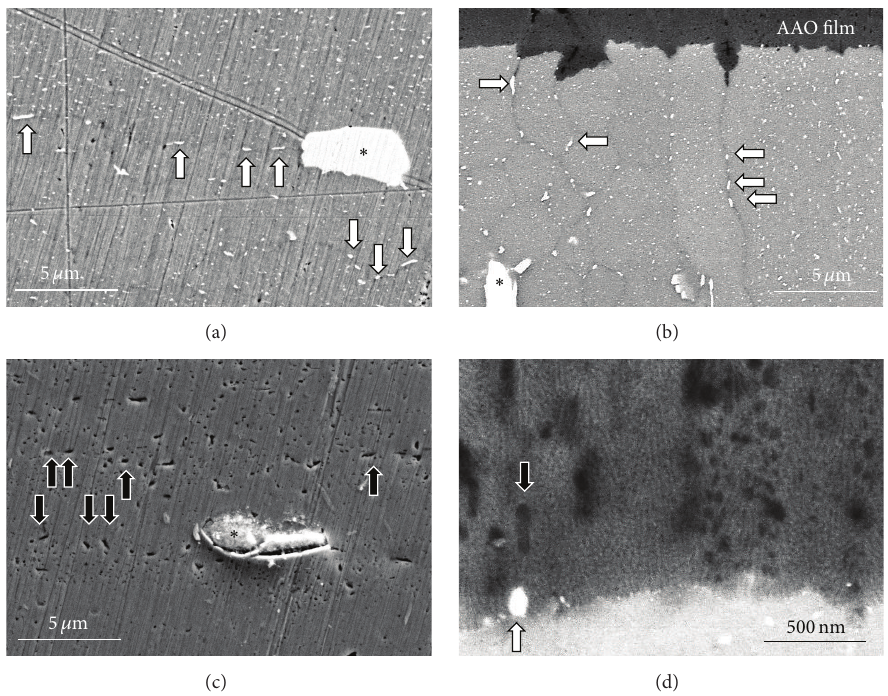
Figure 2: The microstructure of EN AW-7075 T73 in (a) planar view and (b) cross section (with the AAO film on top), and the AAO film formed by potentiodynamic anodising of this alloy in 0.4 M sulphuric acid in (c) planar view and (d) cross section showing the behaviour of coarse constituent particles resistant to anodising (marked by asterisks) and IC particles along grain boundaries (some ones are marked by white arrows) and in the grain interior resulting in voids in the AAO film (some ones are marked by black arrows).